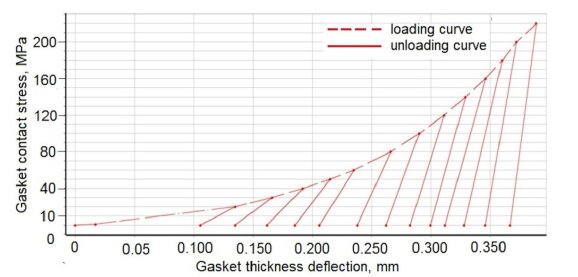
Figure 5: The characteristic of FG_1 gasket describing the deforma- tion level as a function of contact stress